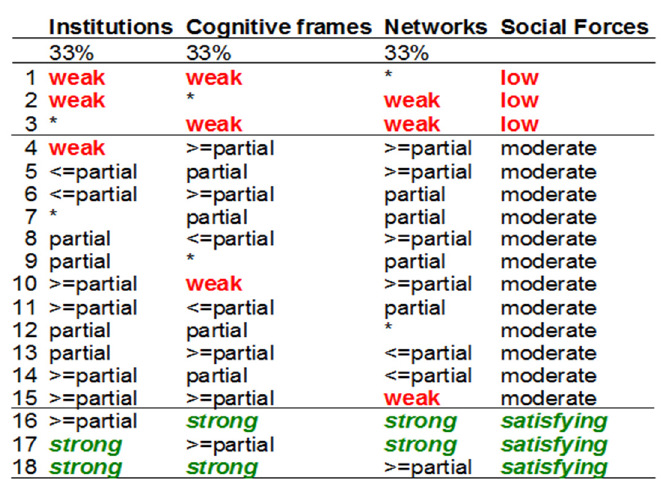
Figure A4. Utility function of the aggregated attribute learning organization.